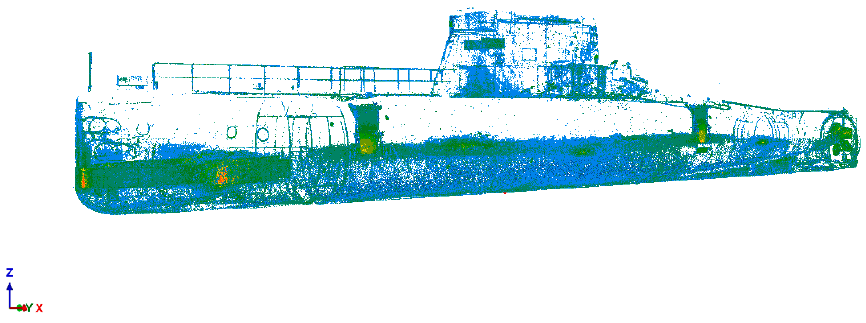
Figure 9. The obtained point cloud of the ship hull. Figure 9 . The obtained point cloud of the ship hull . Figure 9 . The obtained point cloud of the ship hull . Figure 9 . The obtained point cloud of the ship hull .